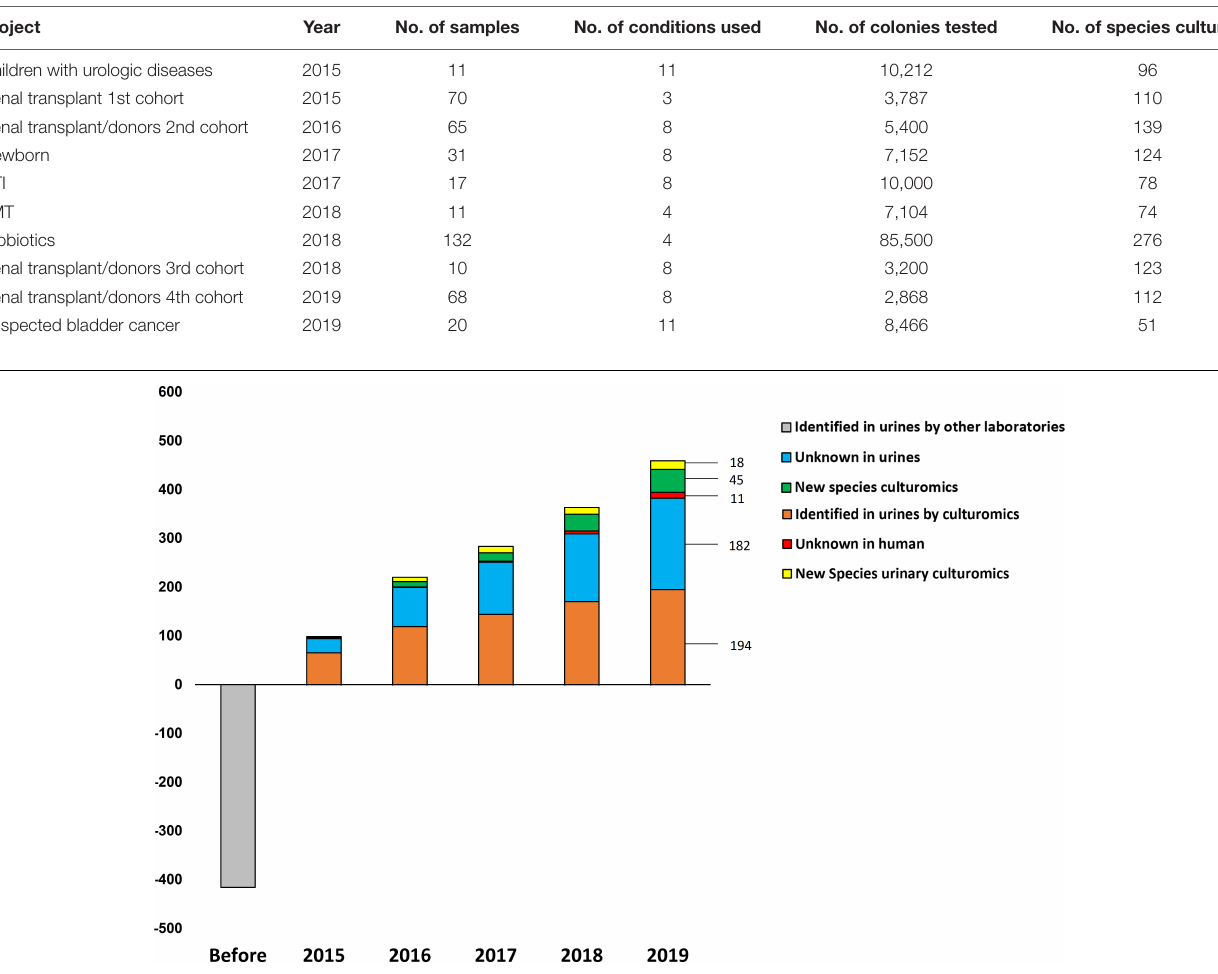
TABLE 1 | Summary of the different projects included in this study.